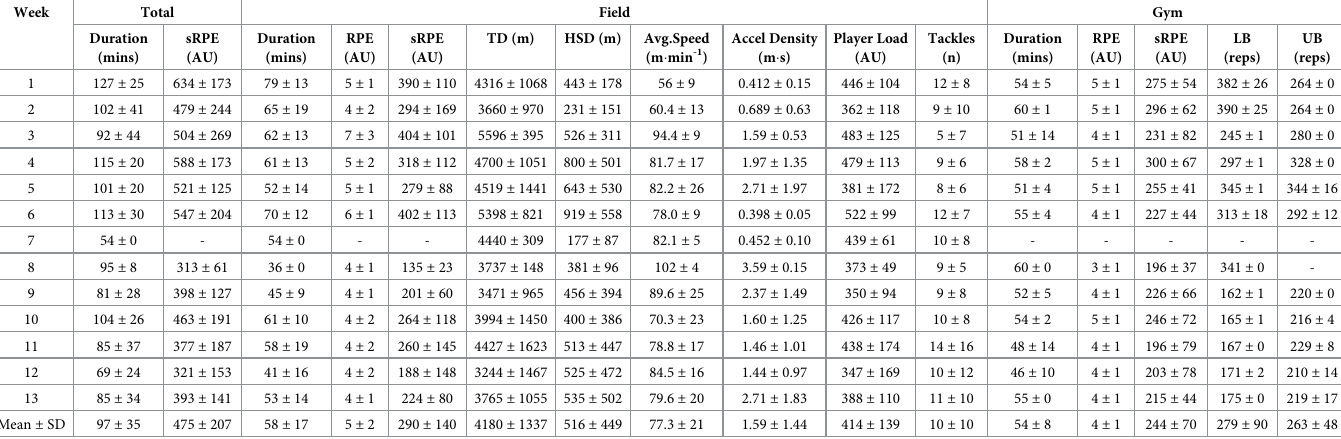
Table 2. Mean (Mean ± SD) sessional training load during an academy rugby league